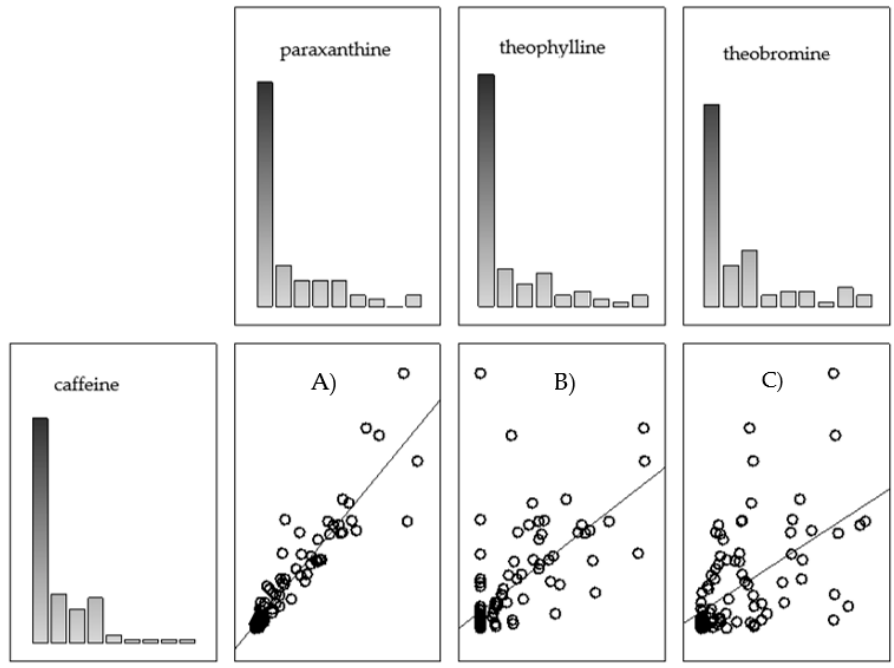
Figure 3. Graphical correlation coefficients ( r ) calculated for the relationship between caffeine content and the content of its metabolites—paraxanthine (A), theophylline (B), and theobromine (C).